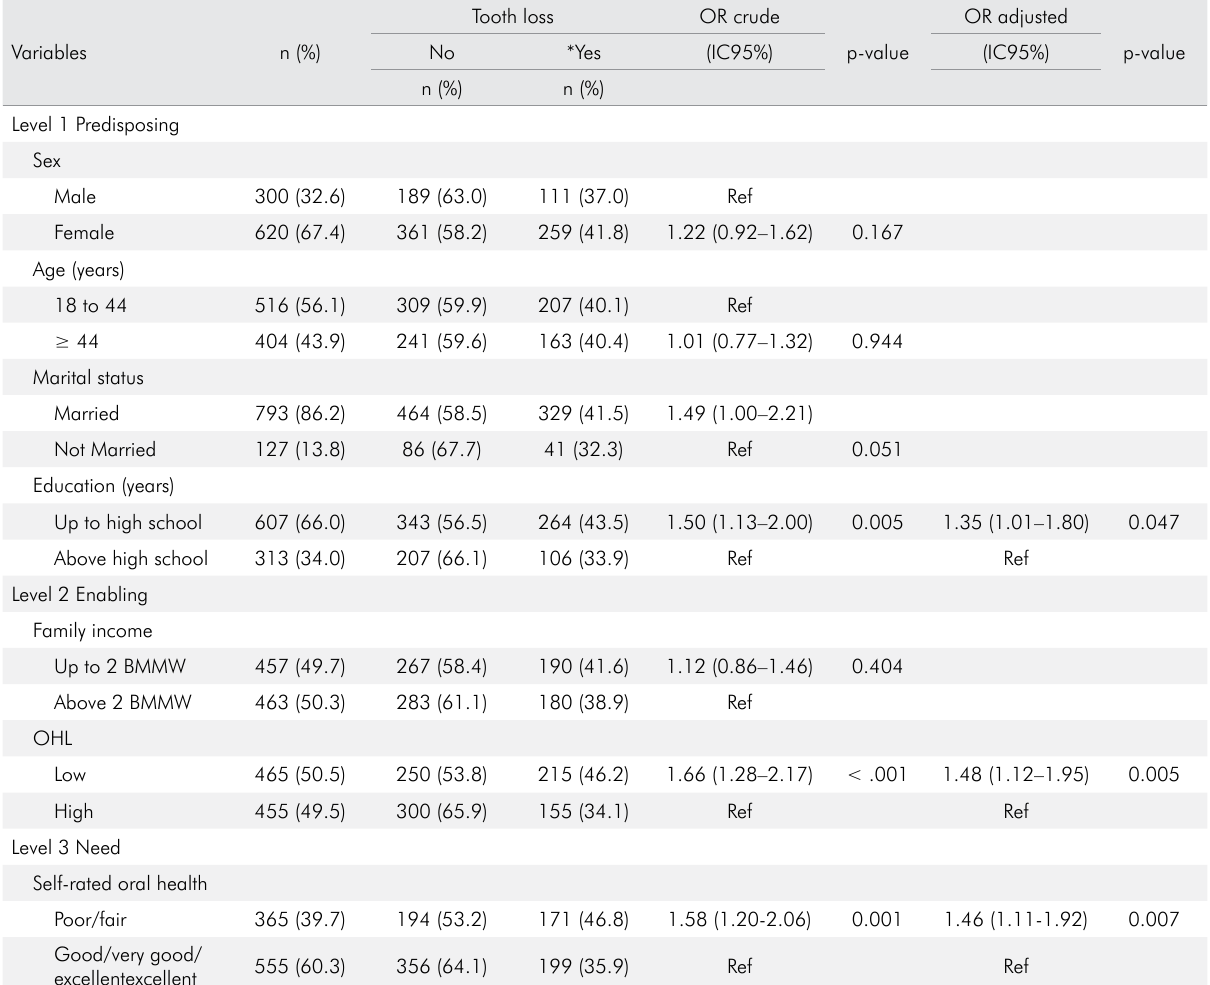
Table 1. Analysis (crude and adjusted) of the associations between tooth loss and independent variables.